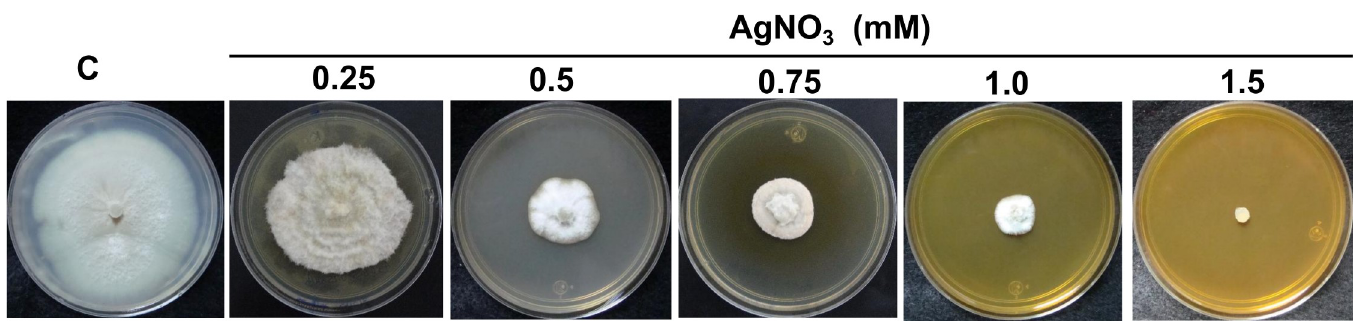
Fig 2. Silver tolerance of the Ag0.5–5 Fusarium scirpi strain. MIC (Minimal Inhibitory Concentration) of AgNO 3 was determined in fungal cultures of PDA agar supplemented with increasing concentrations of AgNO 3.